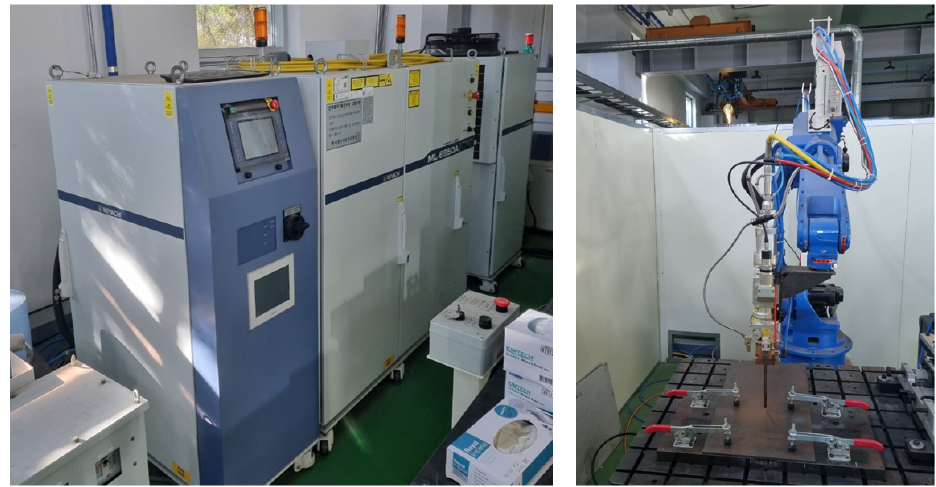
Figure 2. Fiber laser welding system.